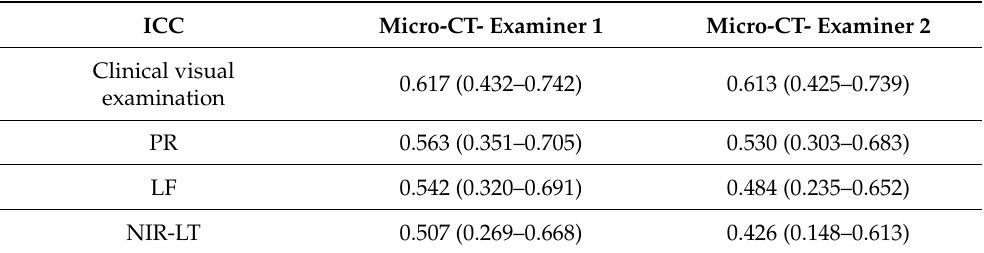
Table 3. Comparison of the consistency of two examiners and each diagnostic method with the micro-CT method.